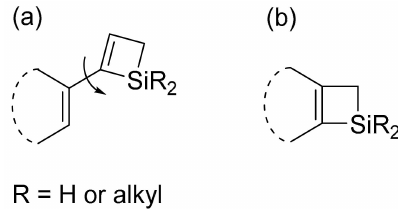
Figure 1. The silacyclobutene (SCB) ring as a substituent ( a ) and fused to an annulene ring ( b